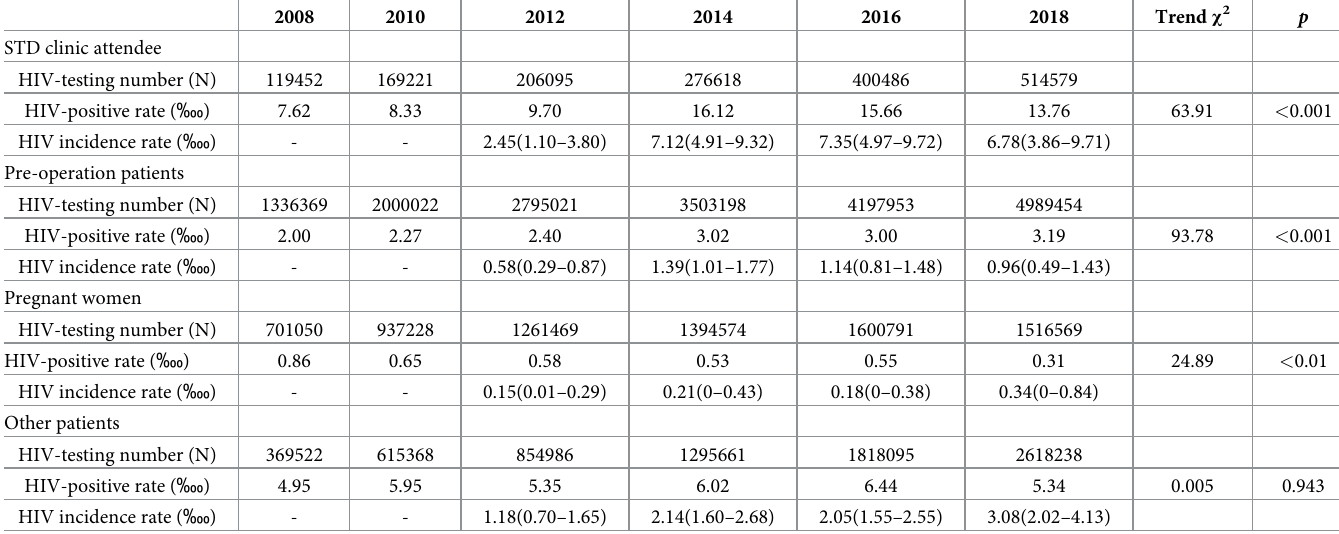
Table 2. Number and HIV screening, HIV positive rate and HIV incidence rate among population in medical